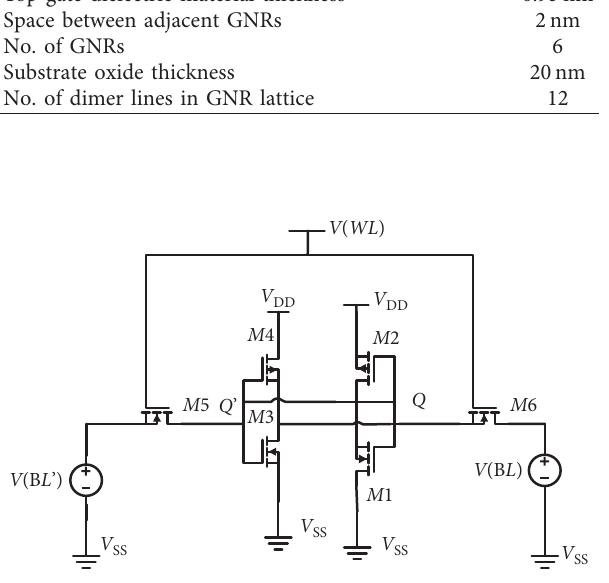
Figure 2: A schematic diagram of a 6T SRAM cell.